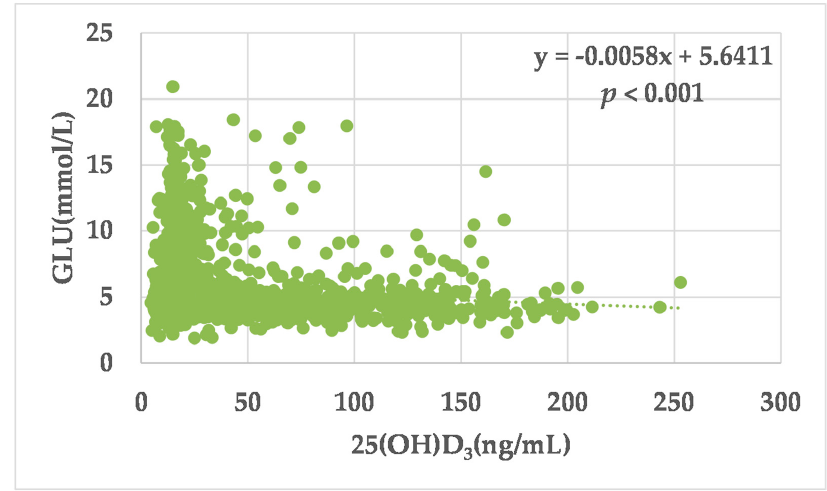
Figure 2. Simple linear correlation between serum GLU and 25(OH)D 3 level.